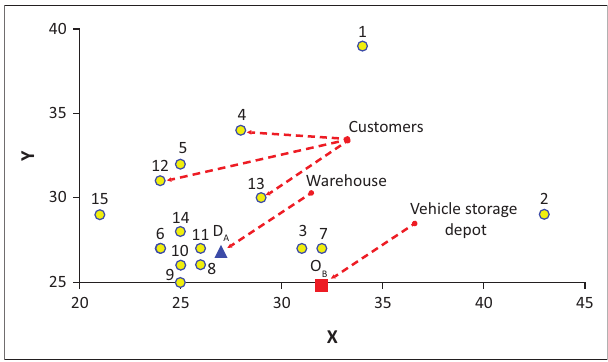
FIGURE 5: Collection, delivery and vehicle storage locations of the real problem.